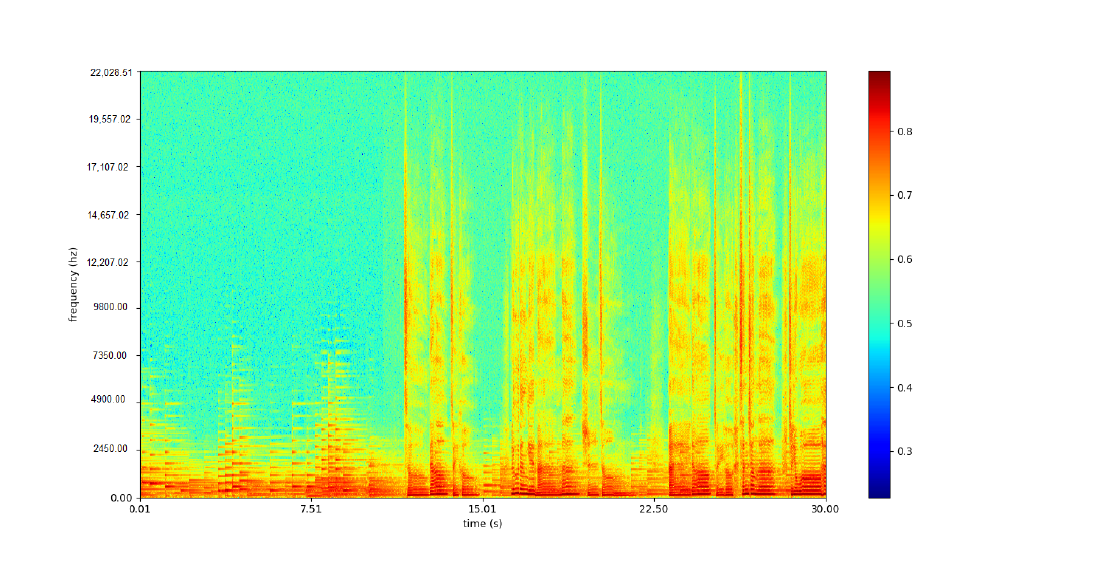
Figure 11. The spectrum of the vocal signal of a song from iKala.